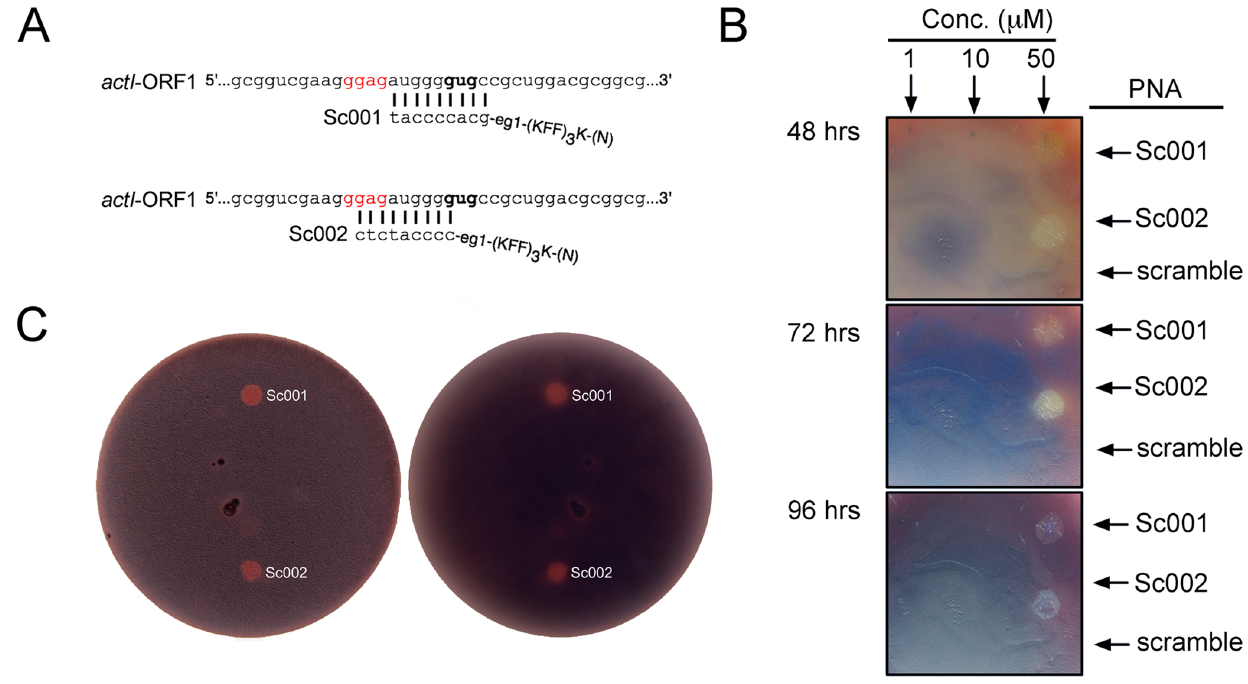
Figure 1. RNA silencing using peptide-PNA. (A) Schematic diagram representing the binding site of antisense peptide-PNAs designed to prevent transcription of act I-ORF1. The start codon of act I-ORF1 is shown in bold, the putative Shine-Dalgarno site in red. Sc001 and Sc002 differ in the degree of coverage of the start codon. (B) Demonstration of the ability of peptide-PNAs to silence production of actinorhodin in S. coelicolor . Peptide-PNA solutions were applied to a lawn of S. coelicolor (after 24 hrs) on MPCA agar and incubation continued for a further 72 hrs. Repression of actinorhodin production is clearly visible with 50 m M treatment using either Sc001 or Sc002; no reduction in actinorhodin production was evident when a scramble-PNA with limited complementarity to the S. coelicolor genome was used at the same concentration. (C) Peptide-PNA solutions were applied directly to a lawn of S. coelicolor MT1110 on ISP-4 agar and were photographed from on top (left) and from bottom (right) after 96 hrs incubation at 28 u